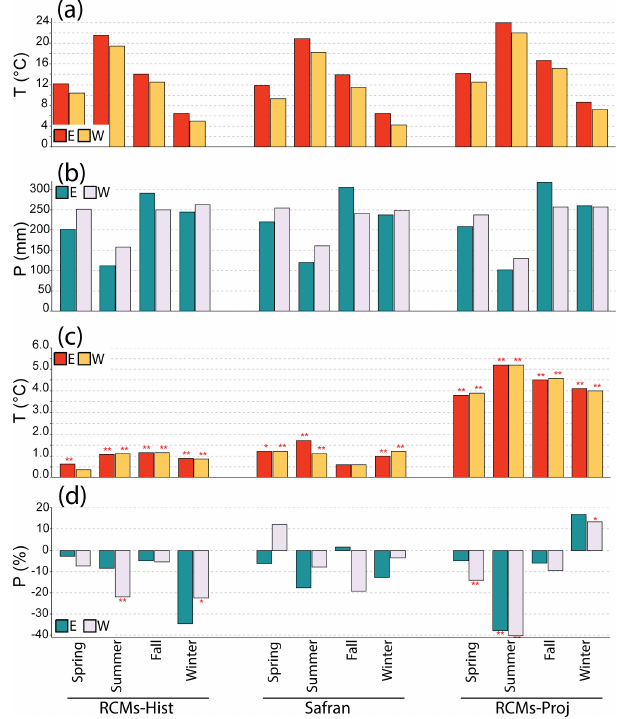
Figure 5. Comparison between Safran and RCMs precipitation and temperature for the historical period 1959–2005 and for the projected period 2006–2100. RCMs-Hist stands for the historical period of RCMs, whereas RCMs-Proj is for the projected period 2006–2100 (a, b) mean annual temperatures and precipitation, re- spectively, and (c, d) Mann–Kendall linear trend of temperatures and precipitation,